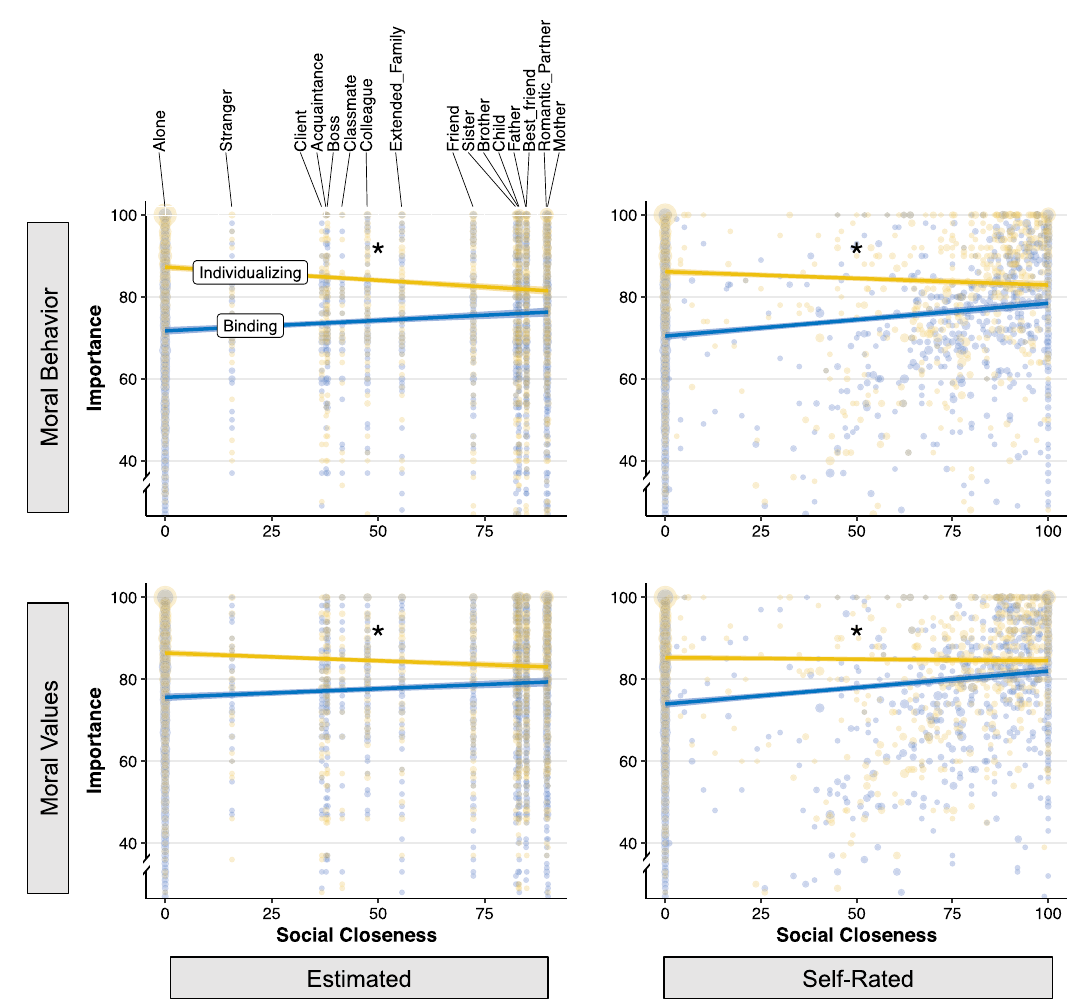
Fig. 2 Social closeness predicts the importance people afford binding versus individualizing values. The left two panels show the association between moral importance rated by people in the presence of various social relationships ( n = 2016) and the social closeness of those relationships estimated by a separate sample ( n = 110). The right two panels show the associations between moral importance and how close participants themselves felt to whomever they were currently with. The upper two panels re fl ect ratings of the importance of moral behaviors; the lower panels the importance of moral values. Alone participants were coded as having a social closeness of 0. Ribbons indicate SEM, and dots re fl ect individual ratings of moral importance, with sizes scaled to re fl ect multiple values on the same point. Points with moral importance <30 (<5% of total sample) have been omitted for the visualization. Source data are provided as a Source data fi le. *Differences between slopes signi fi cant at p <